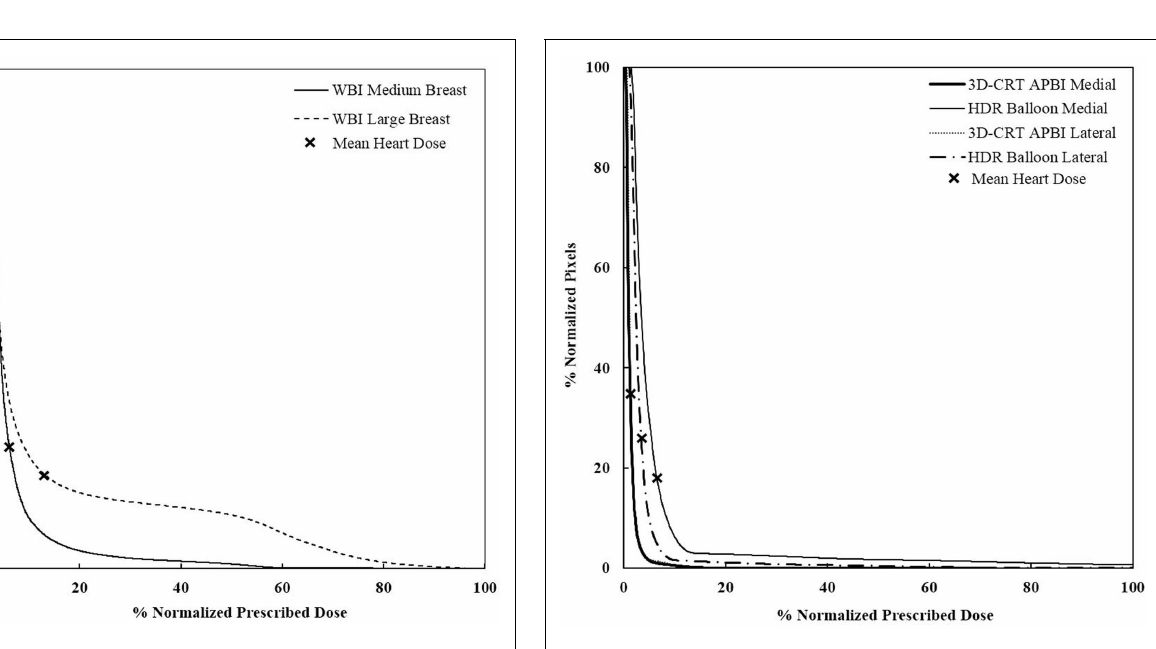
FIGURE 6 | DVHs forWBI of medium and large breasts . More heart is receiving a higher dose for large breasts.WBI, whole breast irradiation.